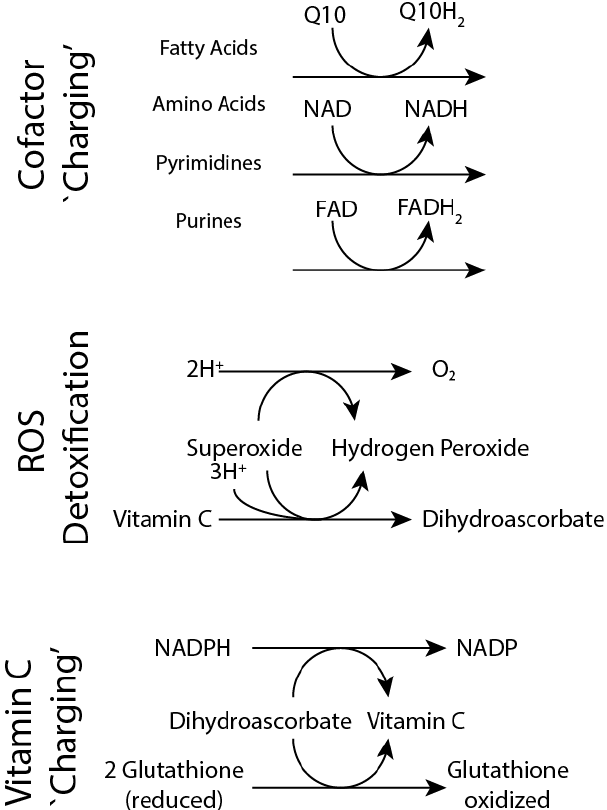
Figure 9. Detailed evaluation of the unique sets of reactions that were active in Urat1/RST KO but not wildtype mice revealed that the metabolic alterations and changes in the seemingly disparate sub-systems are actually coordinated/complementary reactions related to ROS detoxification and maintaining the redox state of the cell via peroxidation reactions relying on Vitamin C metabolism and maintenance of cofactors in the reduced state. Table 1. Selected reactions and corresponding subsystems that were present in Urat1/Rst KO models but not WT. Superoxide dismutase (SPODM) isoforms in multiple compartments, in addition to ascorbate, metabolize superoxide to hydrogen peroxide. Glutathione and NADPH provide reducing equivalents to ‘recharge’ ascorbate. Sub-script letters specify the compartment (c: cytosol, n: